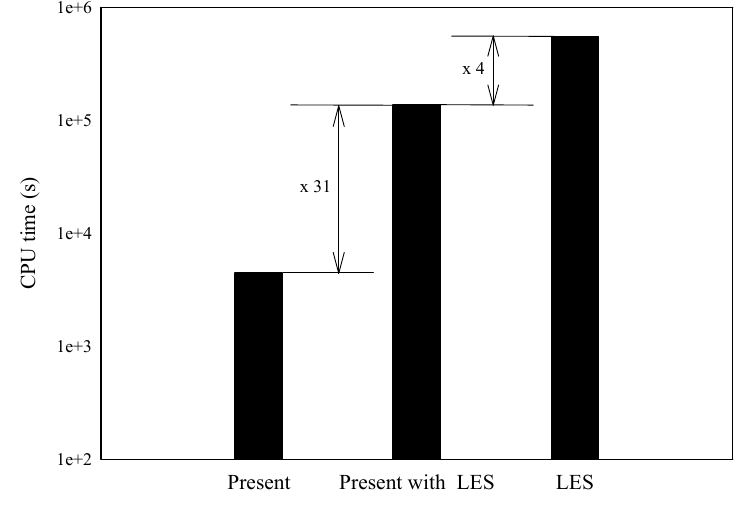
Figure 6. Comparison of CPU time in seconds.